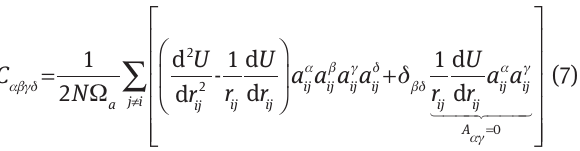
where is the potential energy due to non-bonding interactions. The force of attraction and repulsion ( F each molecule is obtained from the gradient of the poten- tial